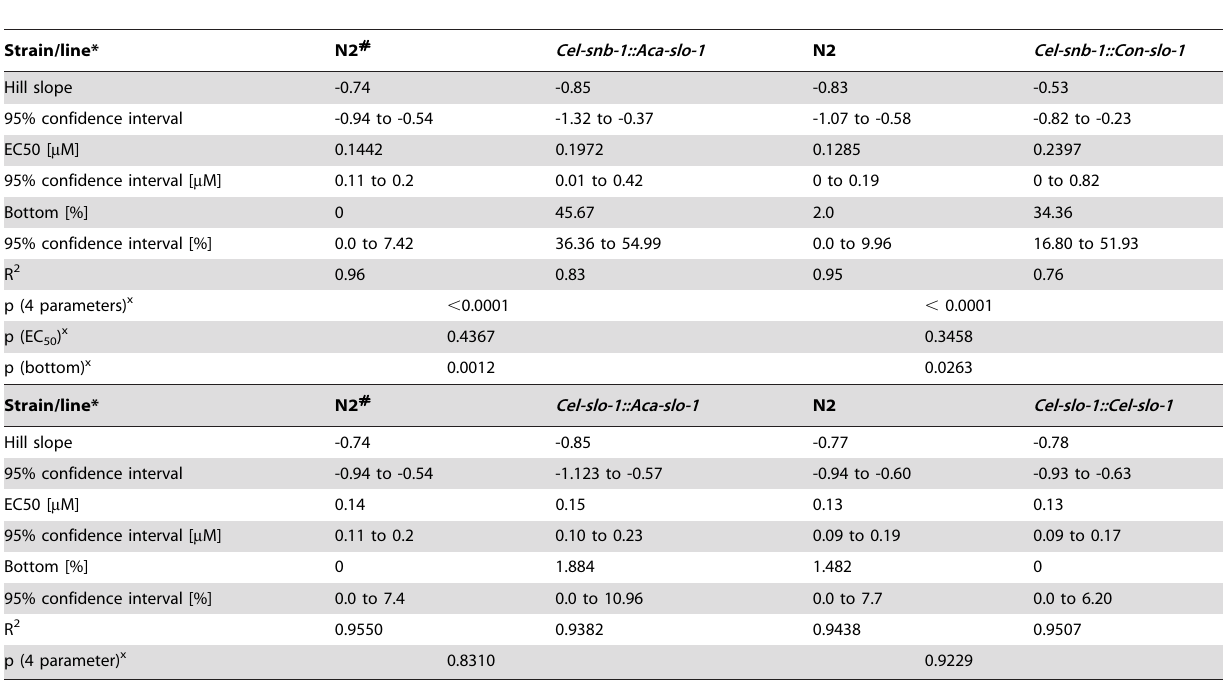
Table 1. A summary of the pharmacological response to emodepside in transgenic lines expressing either C. elegans or parasite slo-1 under the control of C. elegans -derived